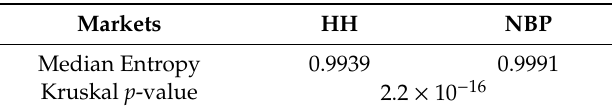
Table 7. Entropy